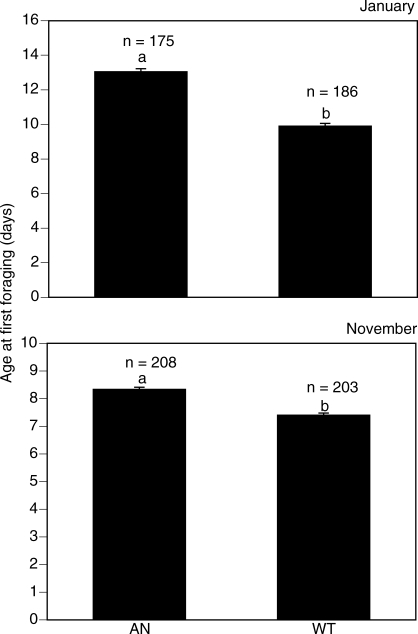
Mean Age at Which the First Workers to Forage Returned from Their First Foraging TripWithin each replicate (January and November), means followed by a different letter are significantly different at the 5% level (based on least significant differences from univariate ANOVA). Bars are standard errors of the means. AN = anarchist colonies; WT = wild-type colonies; n = the sample size.